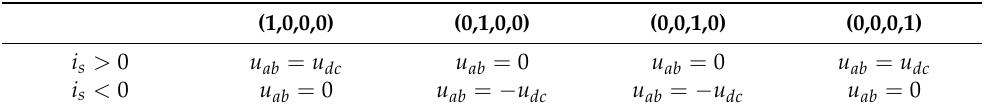
Table 4. The value of u ab in the